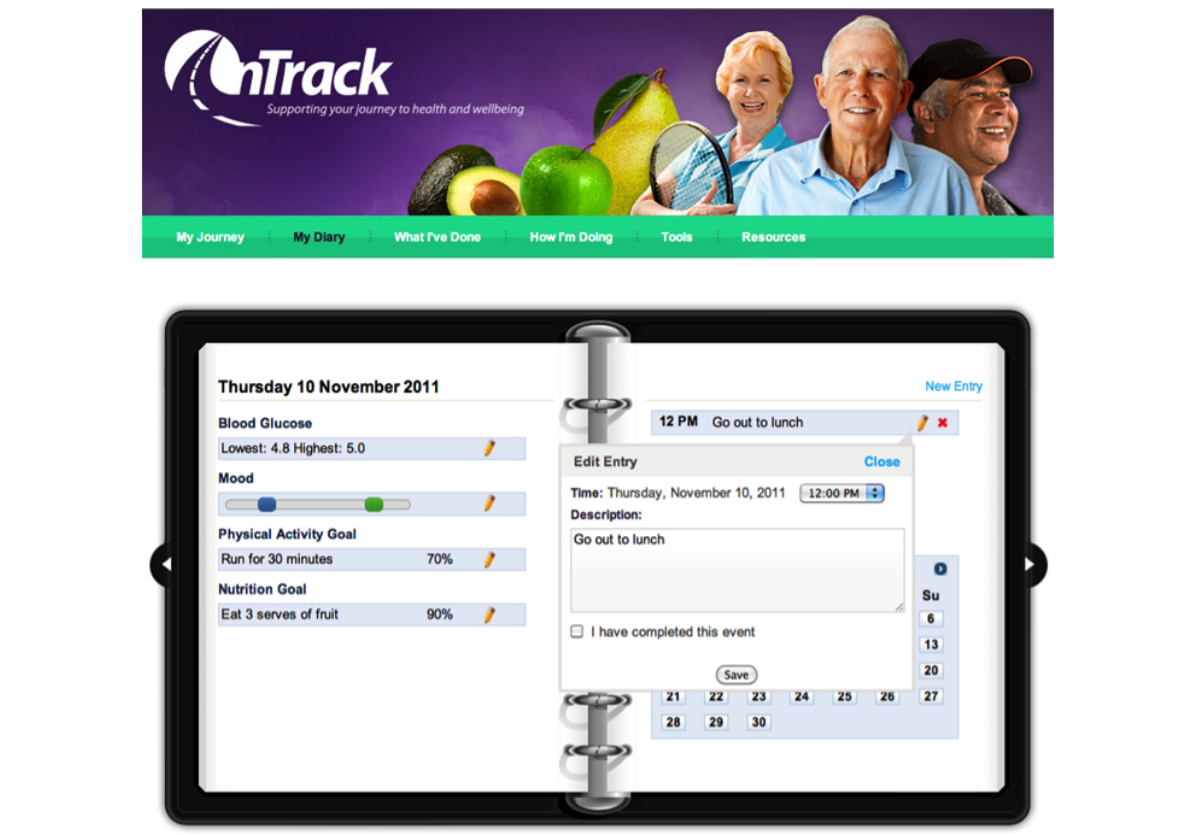
Figure 3. Diary for